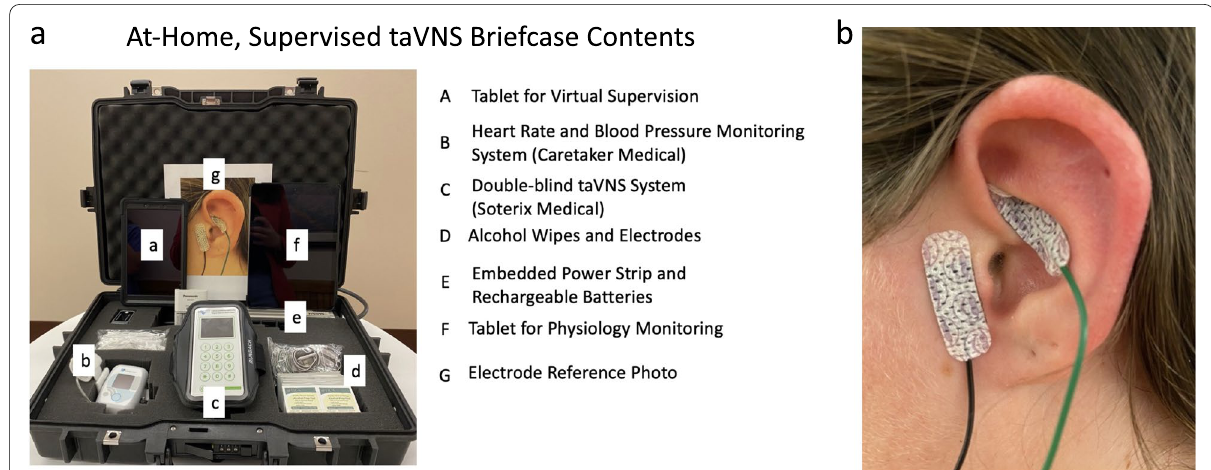
Fig. 2 Overview of Stimulation Methodology. A we created an at-home taVNS kit that included all the components required to safely self-administer taVNS, as well as real-time monitor safety via physio monitoring. B taVNS was administered to participant’s left ear, with the anode placed on the cymba conchae of the ear, and the cathode on the